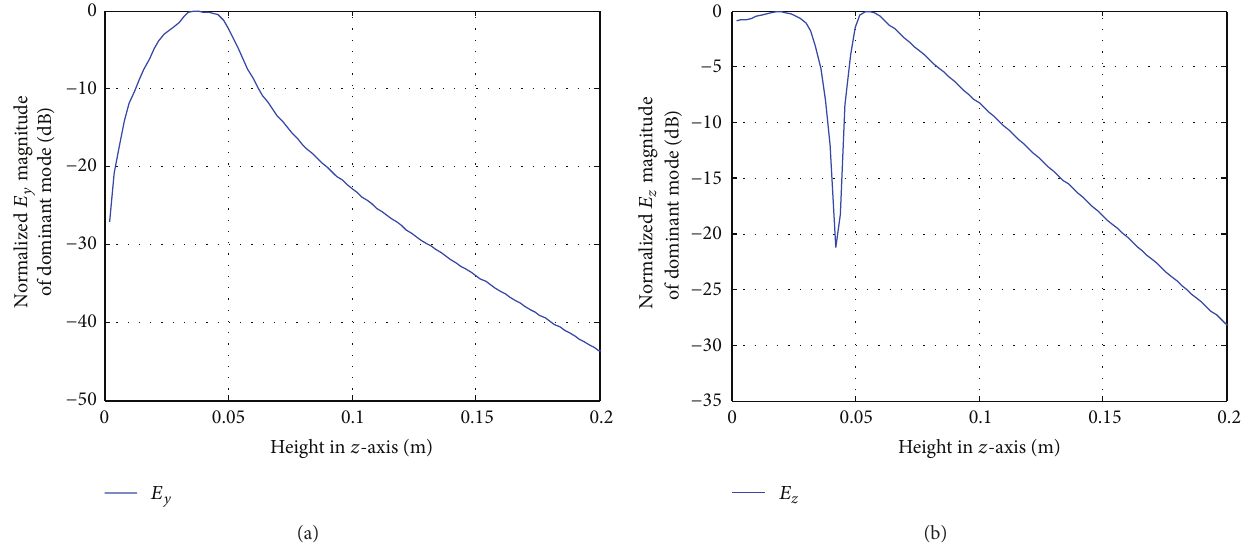
Figure 6: Normalized electric field mode distributions at 390 MHz: (a) 𝐸 𝑦 and (b) 𝐸 𝑧 .